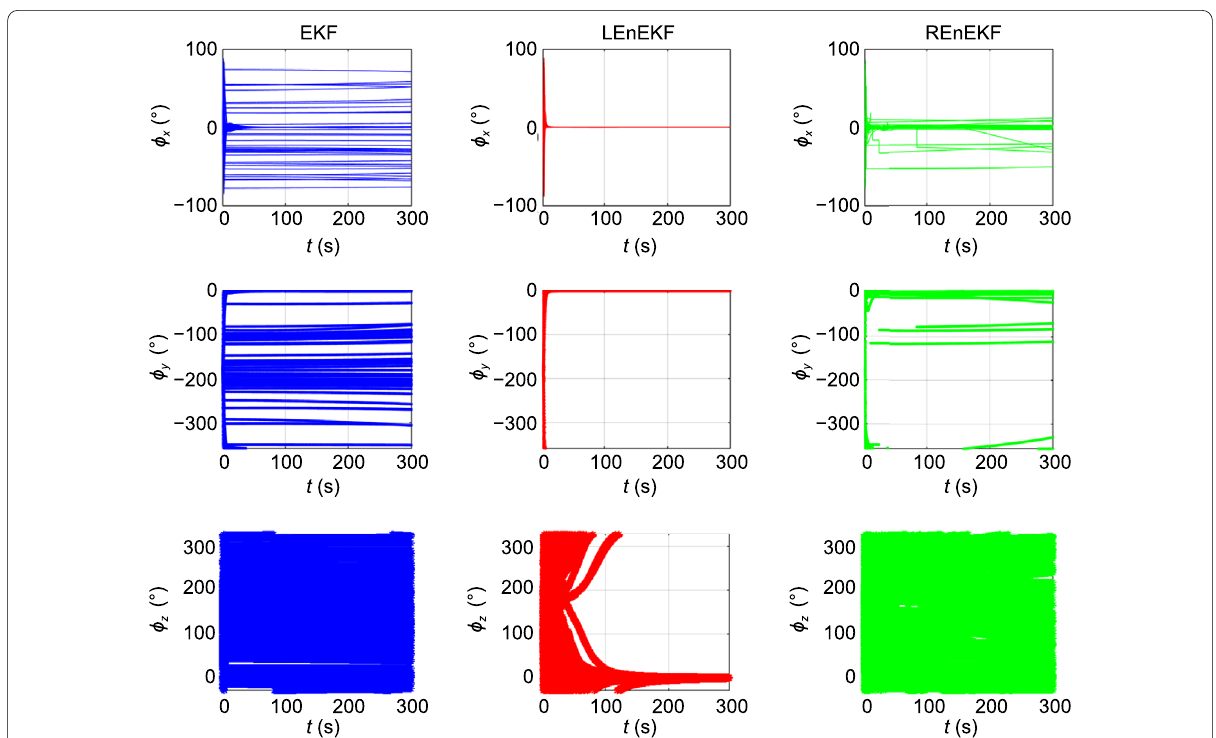
Fig. 1 Roll, pitch, and, yaw angle estimated results in static simulation experiment with large misalignment angle